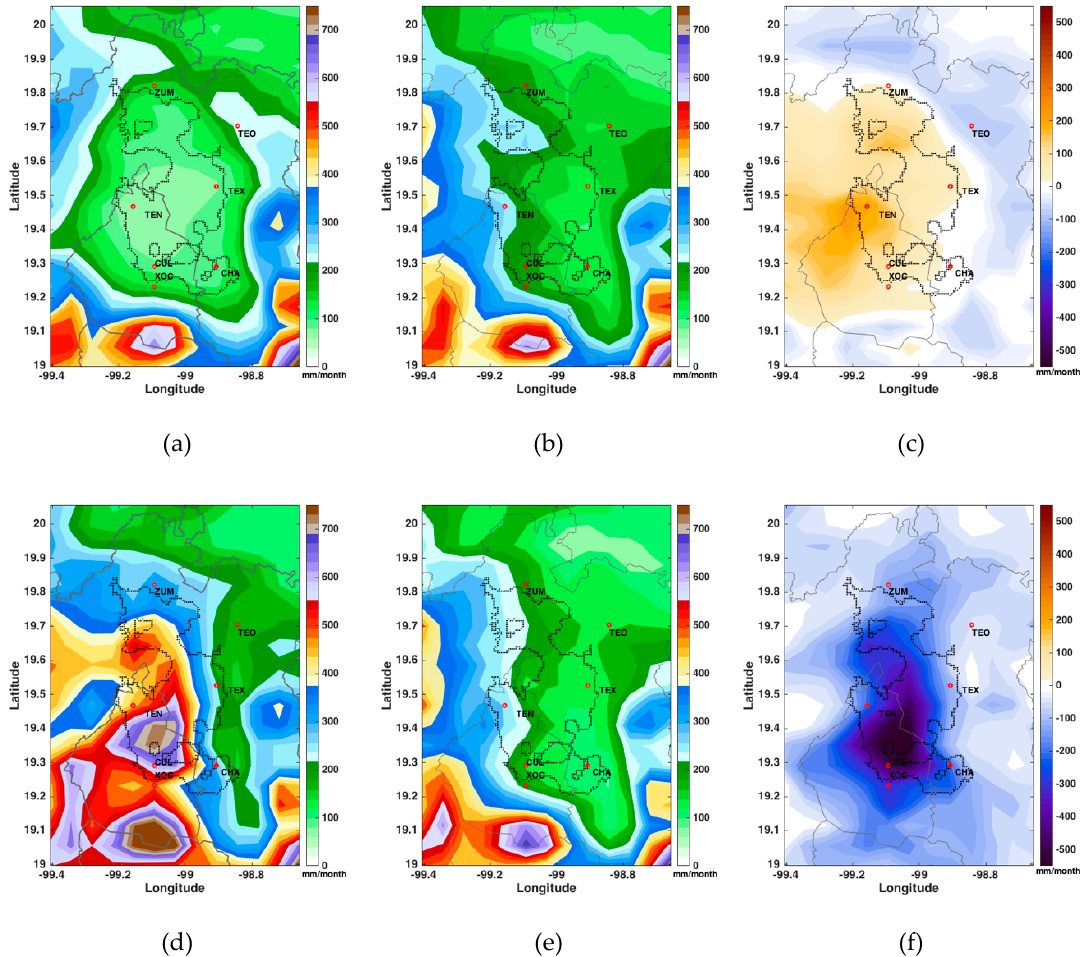
Figure 3. Upper panels: accumulated precipitation for August showing the simulations with L/WRFu ( a ) and NL/WRFu ( b ), both using the uncoupled WRF model, and the difference of results obtained with NL/WRFu and L/WRFu (calculated by results obtained with NL/WRFu minus results obtained with L/WRFu) ( c ). Lower panels: accumulated precipitation for August showing the simulations with L/WRFc ( d ) and NL/WRFc ( e ), both using the WRF-Lake model, and the difference of results obtained with L/WRFc and NL/WRFc (calculated by results obtained with NL/WRFc minus results obtained with L/WRFc) ( f ).